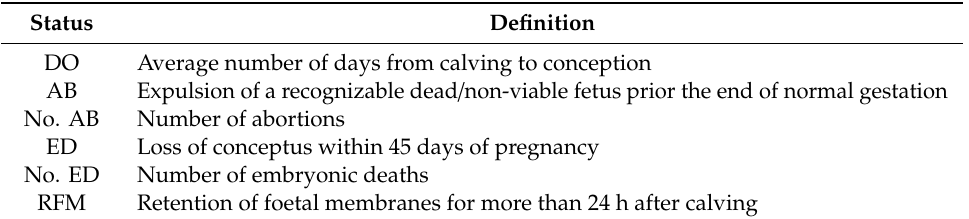
Table 1. Definition of the historical parameters collected for the water bu ff aloes enrolled during the investigation according to Hudson et al. [39] and Toni et al.